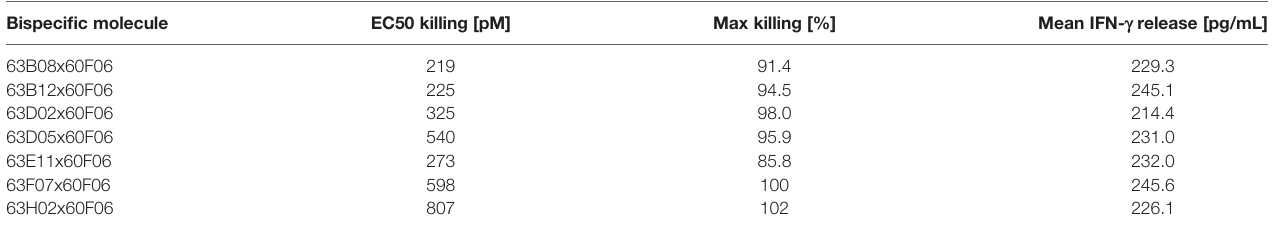
TABLE 2 | NK cell mediated target cell dependent cytotoxic properties and IFN- g release triggered by selected cattle derived ultralong CDR-H3 common light chain bispeci fi c antibodies. Bispeci fi c